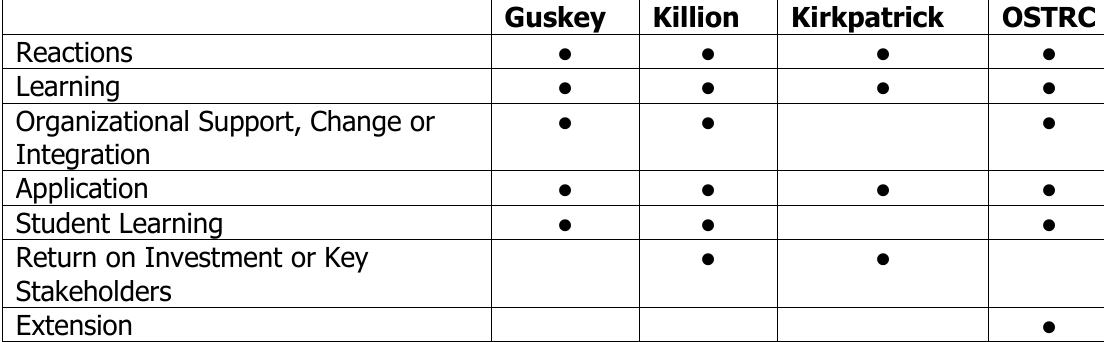
Figure 3 Comparison Chart – Levels of Evaluation Guskey Killion Kirkpatrick